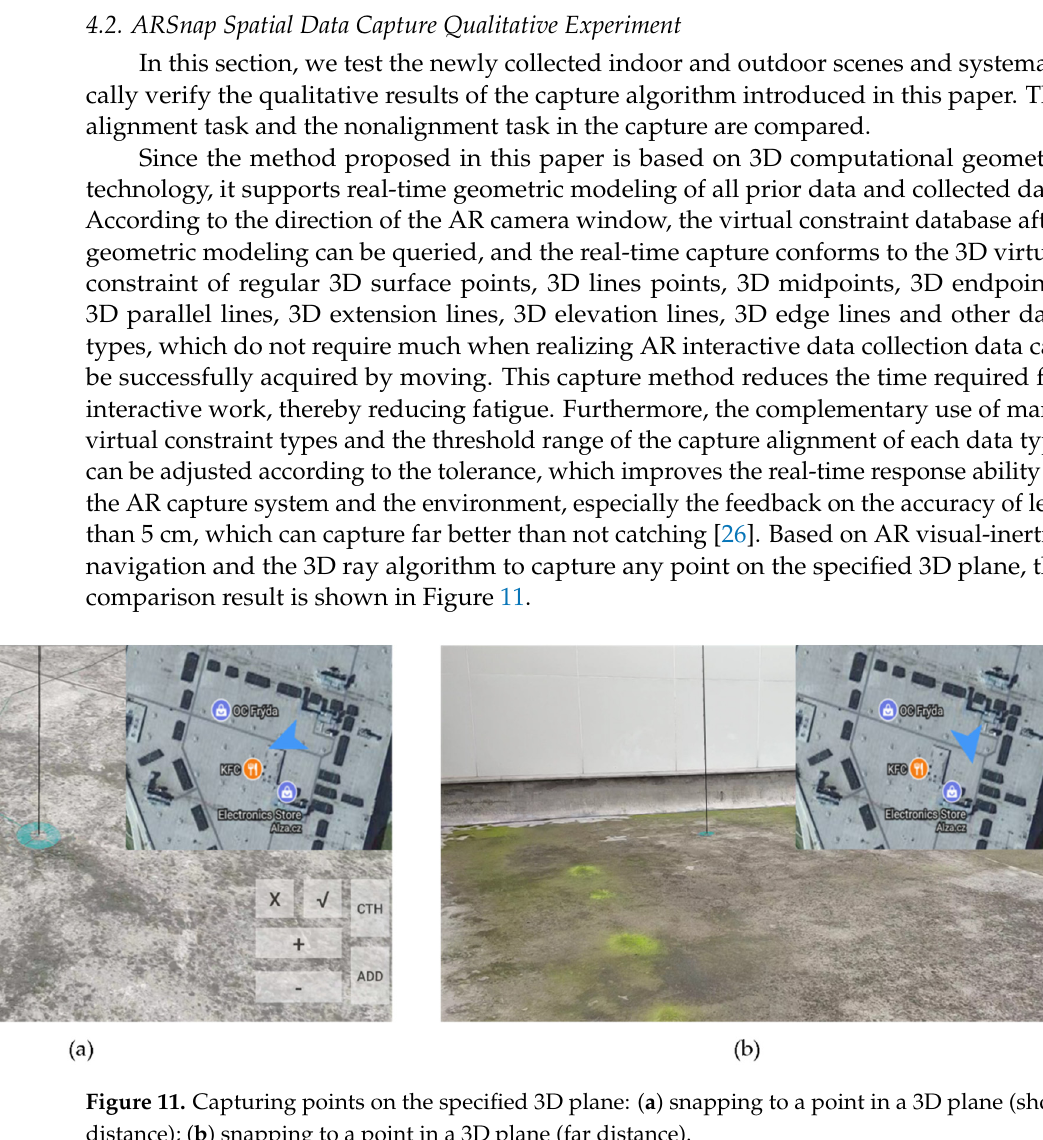
Figure 12. Capturing the extended lines and horizonal lines in 3D space: ( a ) before snapping the extended lines; ( b ) after snapping the extended lines; ( c ) before snapping the horizonal lines; ( d ) after snapping the horizonal lines.